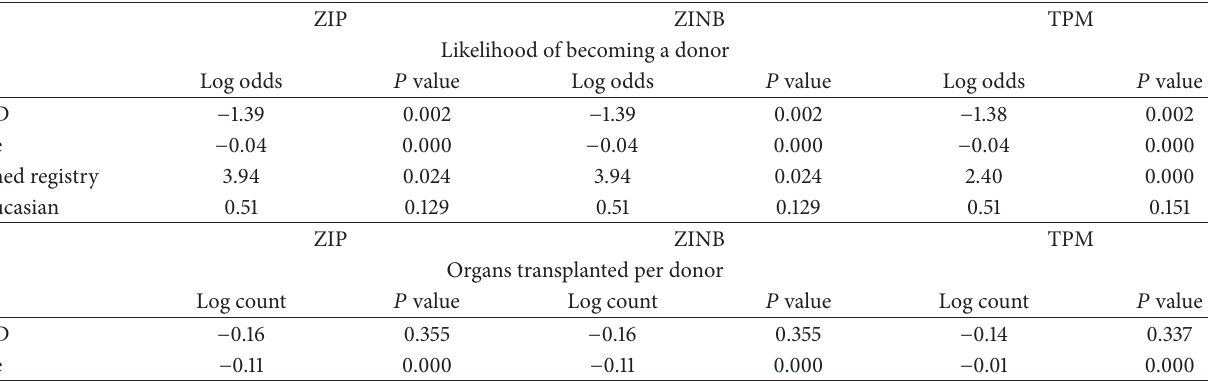
Table 8: Sensitivity analysis-regression